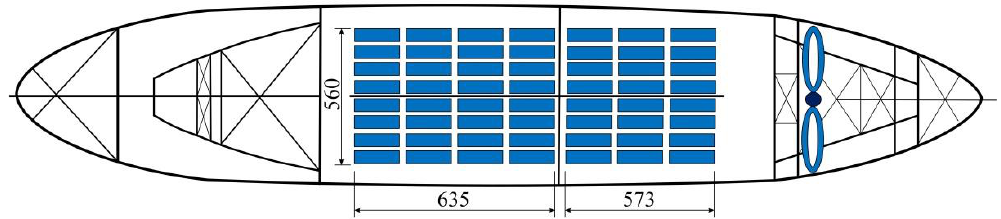
Figure 3. Schematic illustration of the location of the PV modules and a wind turbine (the stated dimensions are in cm).